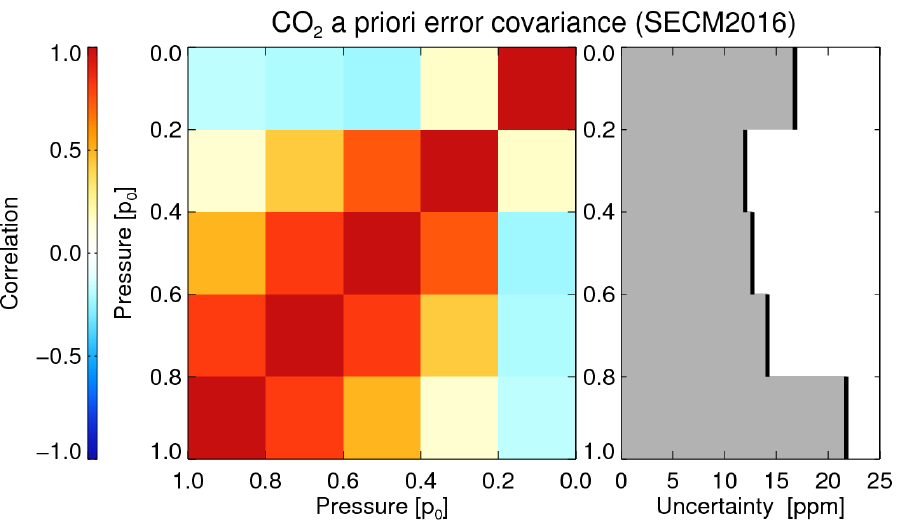
Figure 4. CO 2 a priori error covariance computed from randomly chosen SECM2016 profiles and corresponding CT2016 profiles. The CO 2 layer variances have been up-scaled so that the a priori XCO 2 uncertainty becomes 10ppm (1ppm without scaling). Left : Layer-to-layer correlation matrix of the a priori uncertainty. Right : 1 σ a priori uncertainty.